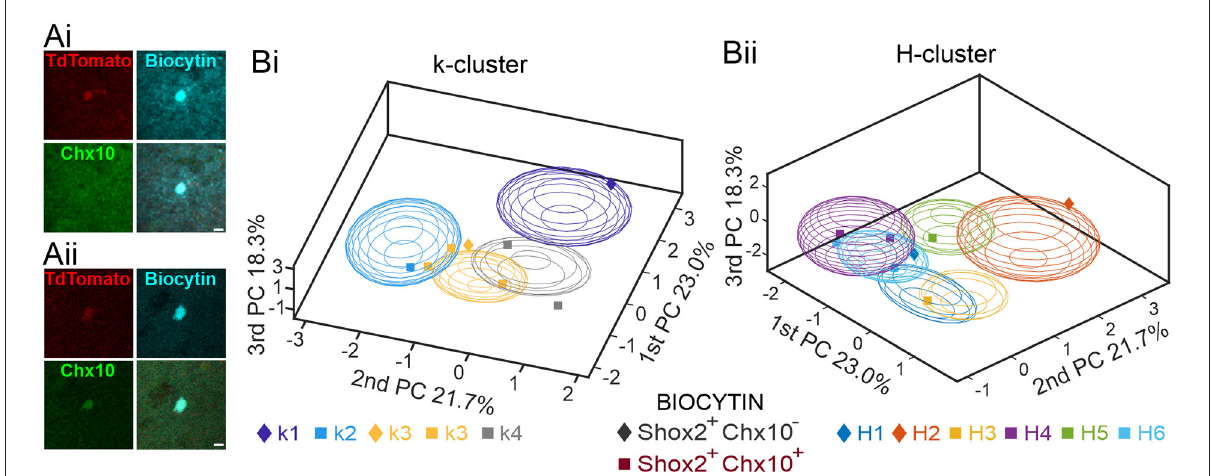
FIGURE8 Validation of clustering analyses with Chx10 staining of Shox2 neurons. (A) Examples of a Shox2 + Chx10 − (Ai) and a Shox2 + Chx10 + (Aii) neuron filled with biocytin (cyan) during recording of an identified Shox2 neuron (tdTomato, red) and stained with a Chx10 antibody. (B) Three-dimensional representations of 8 Shox2 neurons processed for Chx10 identity (Shox2 + Chx10 − , diamonds; Shox2 + Chx10 + , squares) on the three principal components (same as Figure 2B, but different angle) for k-mean clusters (Bi) and hierarchical clustering (Bii) . Ellipsoids are centered on the mean for the three first PC and sem-axes are generated by the standard deviation of each of the three first